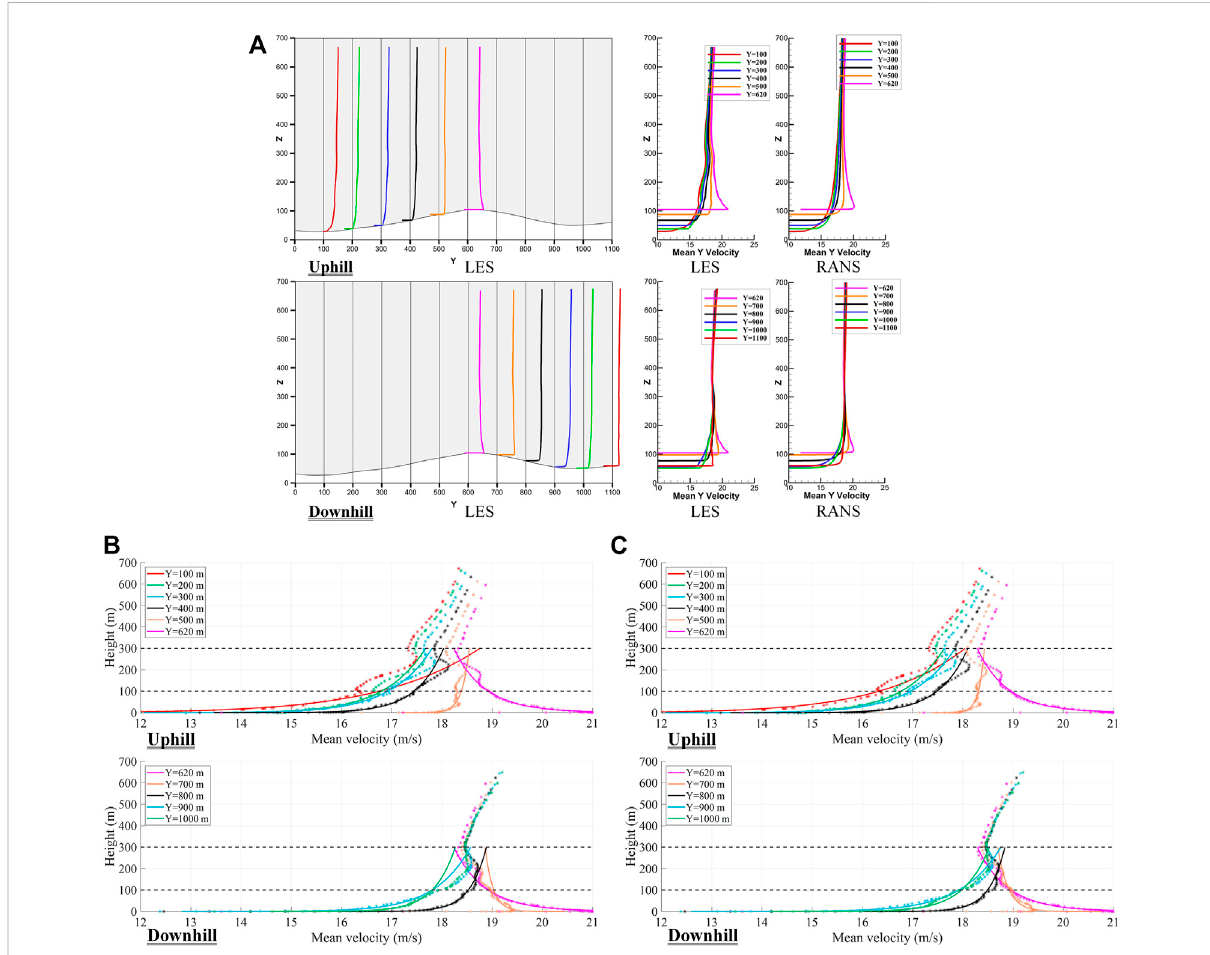
Mean wind speed pro fi les when X=320 m and Y=100 – 620 m (uphill) or Y=620 – 1100 m (downhill): (A) Numerical results with absolute coordinates.Forsub fi guresontheleft,verticalaxis(Z)representsheightinmeters,and horizontalaxis(Y)represents fl owdirection inmeters.Forthe four sub fi gures on the right, vertical axis (Z) represents height in meters, and horizontal axis represents mean wind speed; (B) Numerical results (dottedstarcurves)and fi ttedpower-lawpro fi les(solidcurves)between0and100 mwithcoordinatesrelativetoground; (C) Numericalresults (dotted star curves) and fi tted power-law pro fi les (solid curves) between 0 and 300 m with coordinates relative to